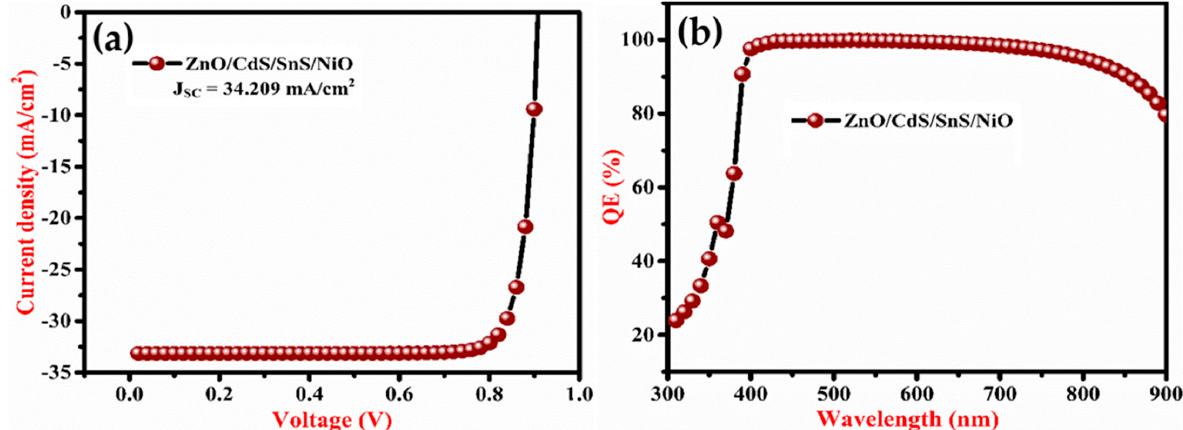
Figure 2. ( a ) J-V curve and ( b ) quantum efficiency of the proposed heterojunction solar